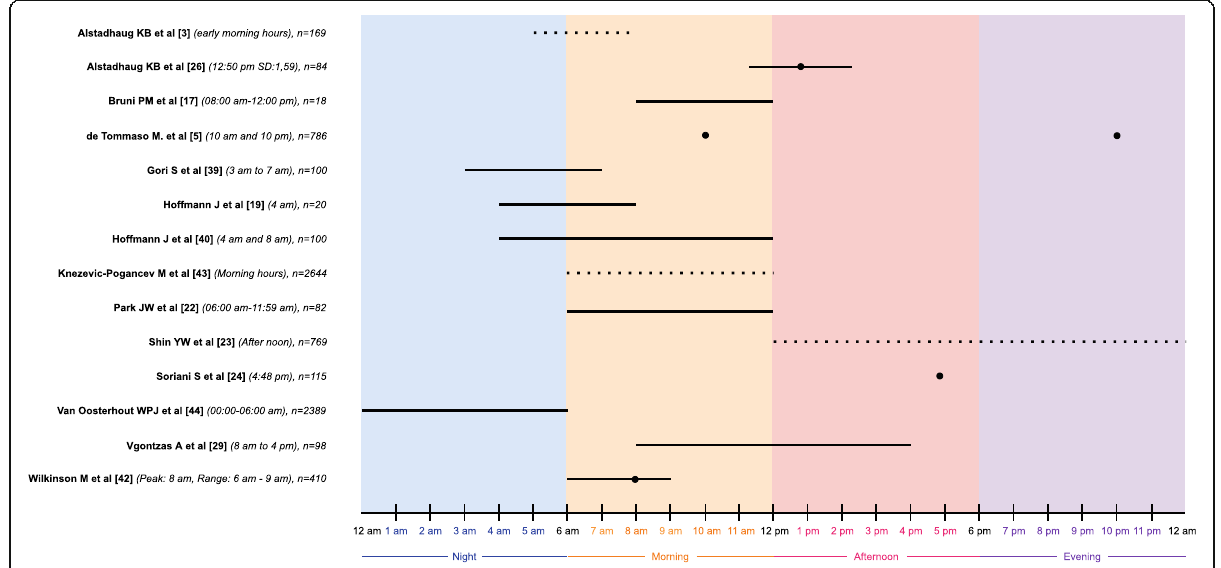
Fig. 2 Circadian (24-hour) distribution of migraine attack onset peak interval for the included studies ( n = 15). One study reported migraine attack onset at any time of the day [32] and thus was not included in the figure. Horizontal black lines indicate the reported time range where most migraine attacks began as reported by the individual studies. Black dot was applied if studies reported a specific peak time. Broken lines were applied for three studies where specific time clocks were unreported [3, 23, 43]. Thus, reporting of early morning hours was estimated to 5 am – 8